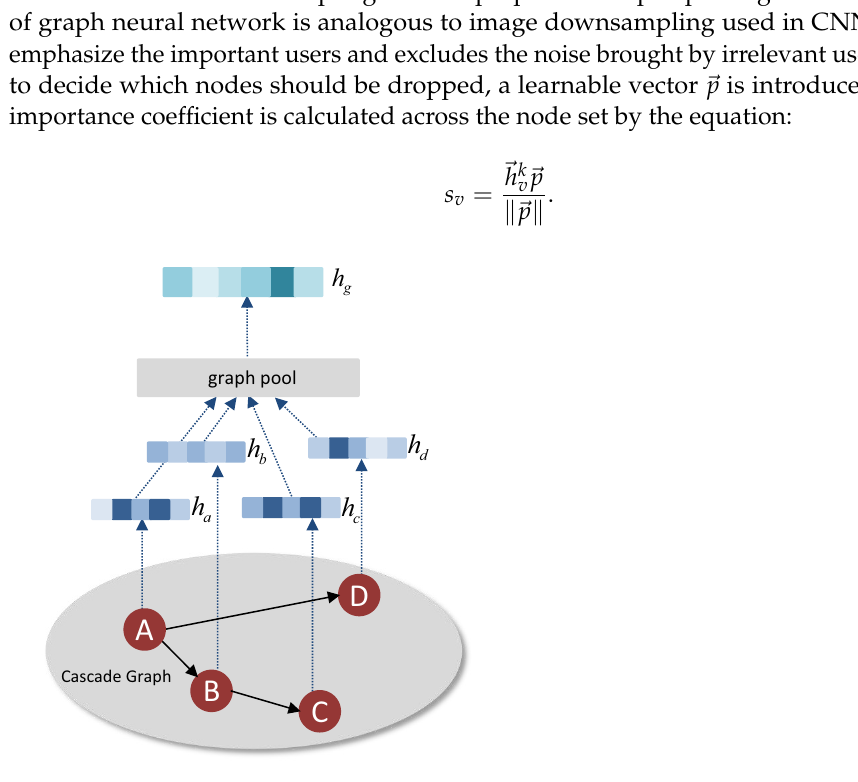
Figure 3. An example of graph pooling process. Cascade graph representation h g is generated from node representation by graph pooling